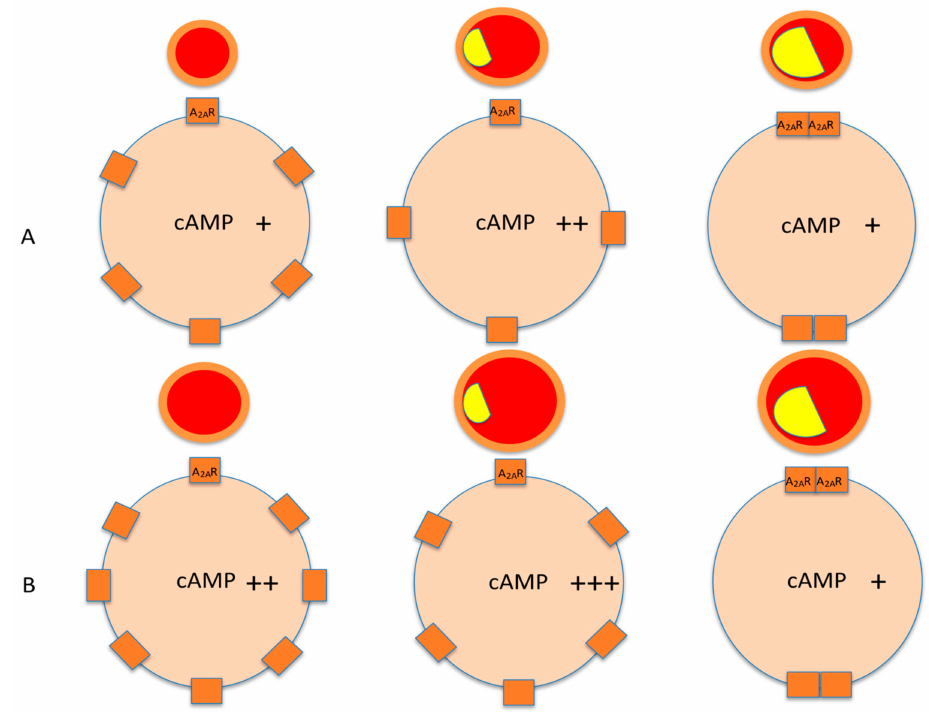
Figure 2. Schematic representation of the pharmacological profile evolution of A 2A adenosine receptors (A 2A R) during progressive atherosclerosis coronary obstruction at rest ( A ) and during exercise test ( B ). Endogenous adenosine release from cardiac myocytes by global myocardial ischemia dilates coronary arteries through cAMP pathway. Adenosine binds to A2 receptors on coronary smooth muscle cells (CoSMCs), increasing cyclic adenosine monophosphate (cAMP), which opens calcium-activated potassium channels. Orange circles represent the arterial wall with CoSMCs. Red circles represent the lumen of the coronary arteries, which is progressively obstructed by atherosclerosis (yellow) and vasodilated by cAMP. During exercise stress testing ( B ), the left panel (healthy artery) shows that cAMP production is higher than that at rest (left panel A) because adenosine is released during exercise and is associated with an increase in coronary vasodilation induced by cAMP (cAMP production and coronary dilation being correlated). Regarding the middle panel (CAD with stenosis), cAMP production is increasing to compensate partial obstruction at rest with more cAMP secretion during exercise. The increase in cAMP production remains effective during effort. In the right panel (CAD with ischemia), the spare receptor phenomenon appears. cAMP production is noneffective because of a small number of oligomerized A 2A R. Note that in the middle panels at rest ( A ) and during effort ( B ), cAMP increases, whereas a lower number of A 2A R are expressed on the cells, which can constitute a signal for